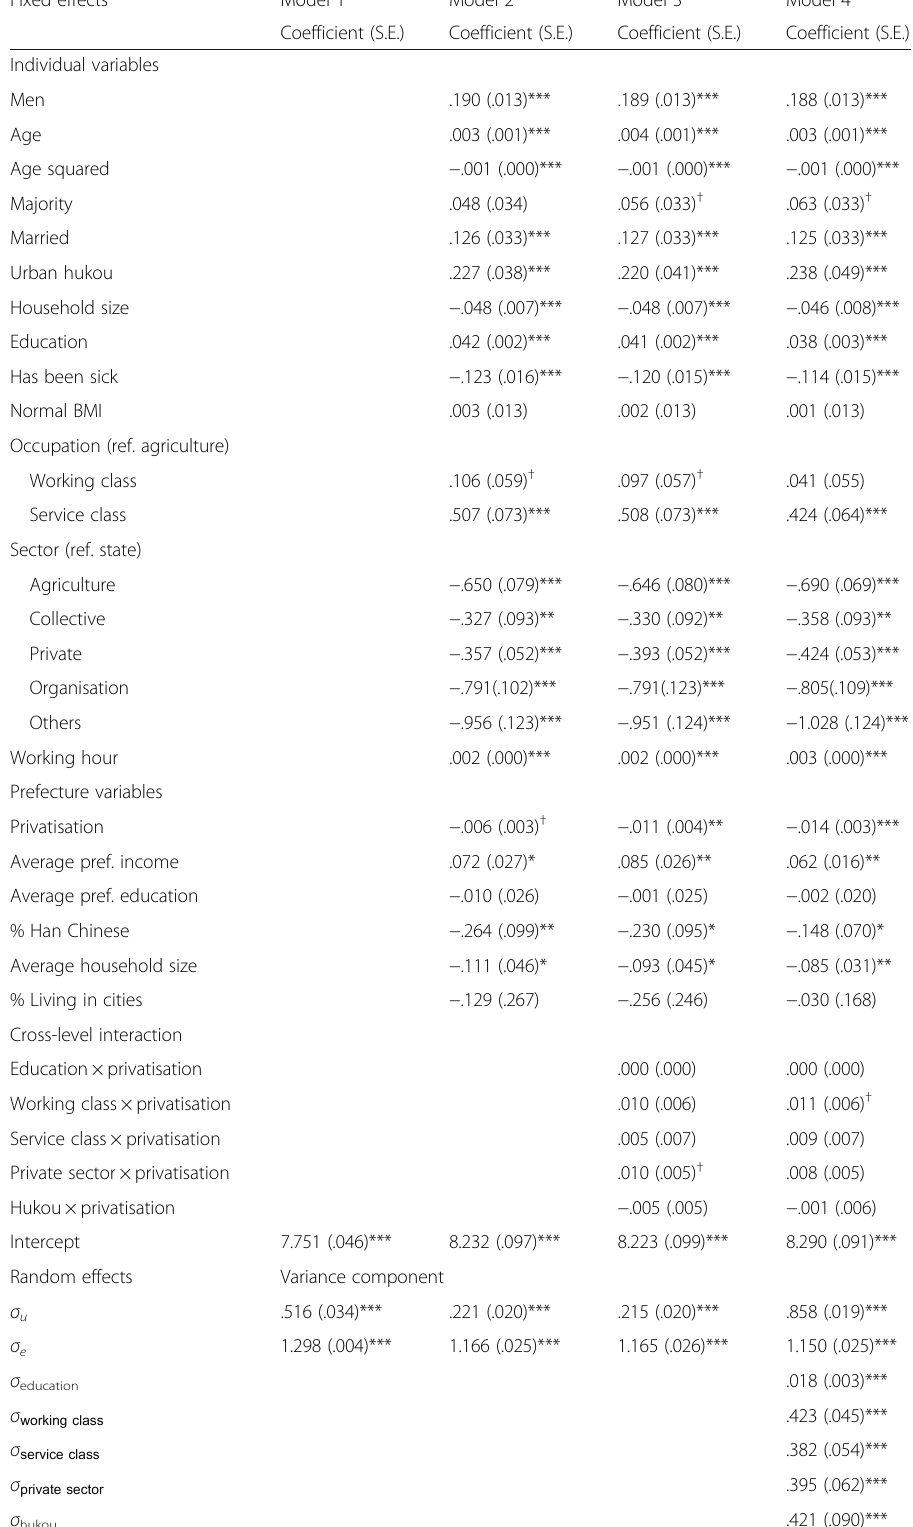
Table 3 Multilevel regression coefficients for individual and aggregated factors on log